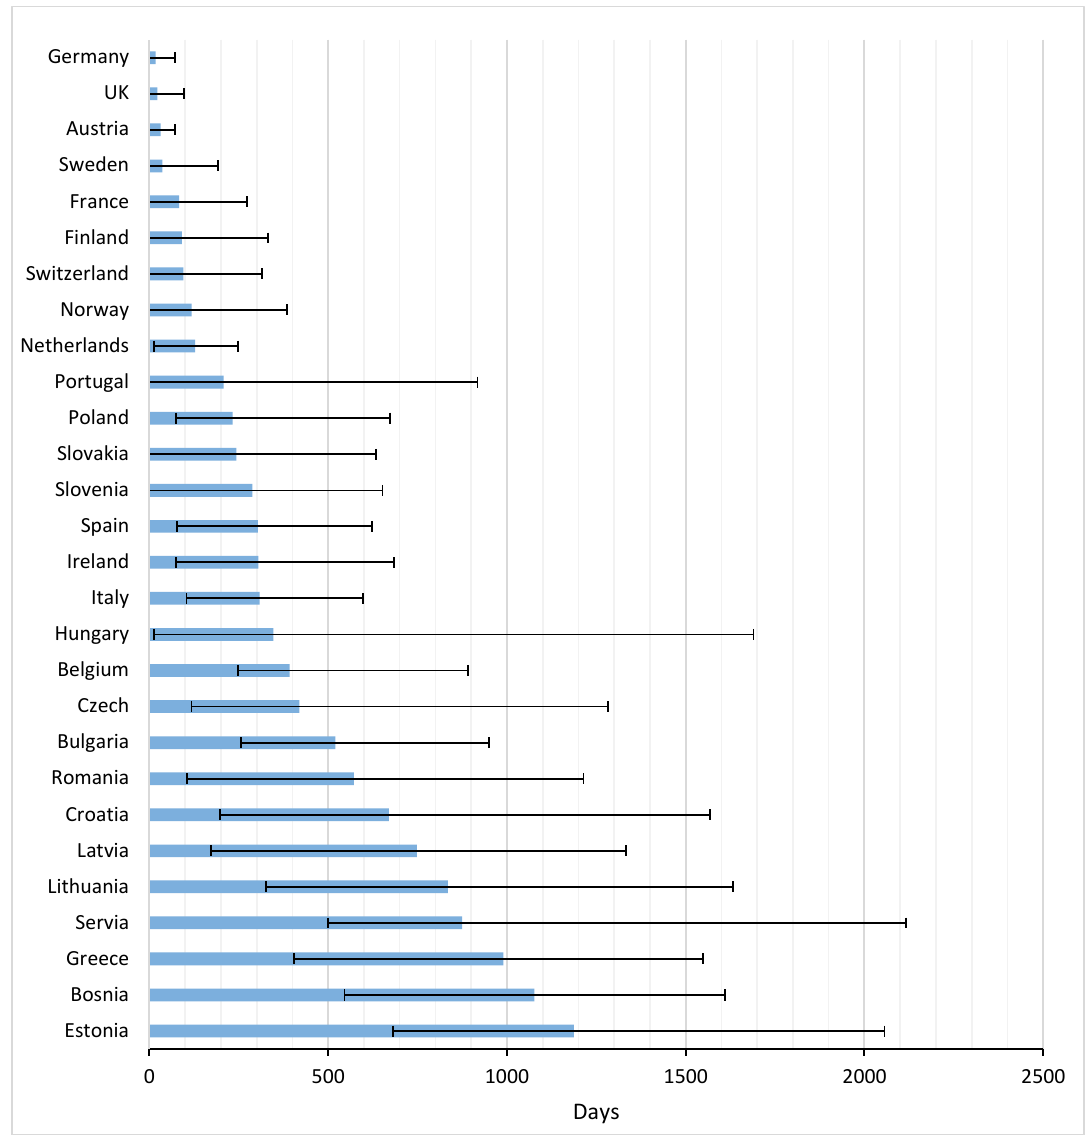
Figure 3. Time to first uptake for 12 newly registered oncological drugs across Europe (in days). The average TTM in Europe amounted to 398 days (range 17–1187 days). In general, patients in Germany, the UK, and Austria had the most rapid potential access, with averages of 17, 22, and 31 days, respectively. Greece and many Eastern European countries were below the European average.